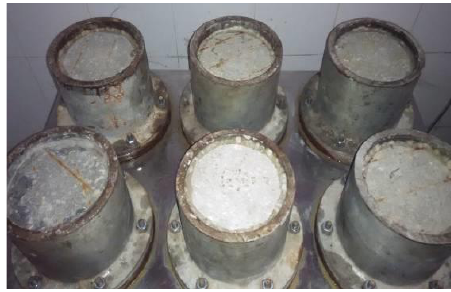
Figure 7. Water penetration resistance test of concrete.